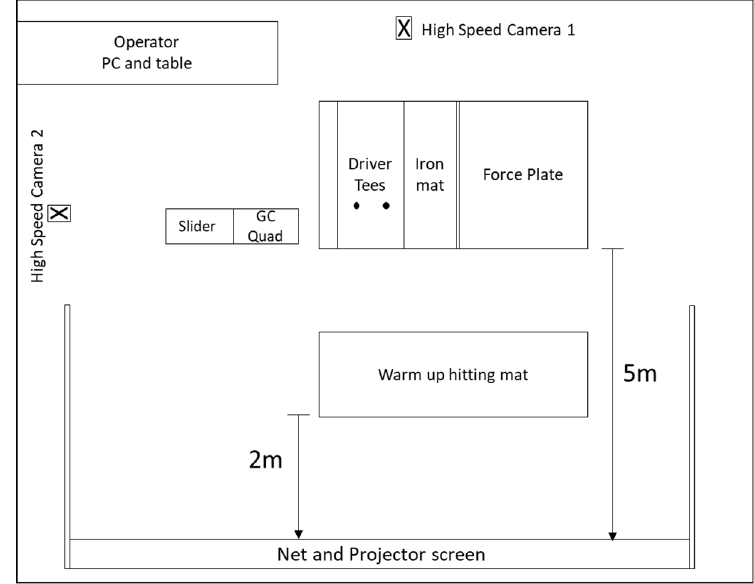
Figure 1. Experimental setup of the room.